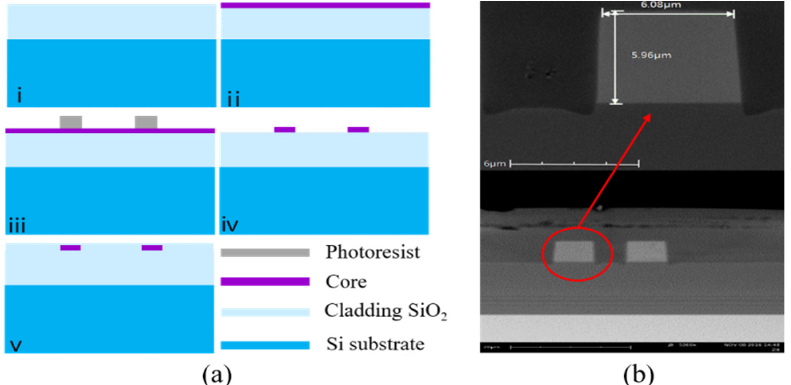
Figure 2. ( a ) Schematic of key fabrication and process steps of the resonator: (i) SiO 2 of the bottom cladding layer by being thermally grown; (ii) core layer by PECVD; (iii) ultraviolet lithography; (iv) dry etch; and (v) SiO 2 of the bottom cladding layer by PECVD. ( b ) SEM image of a coupling region